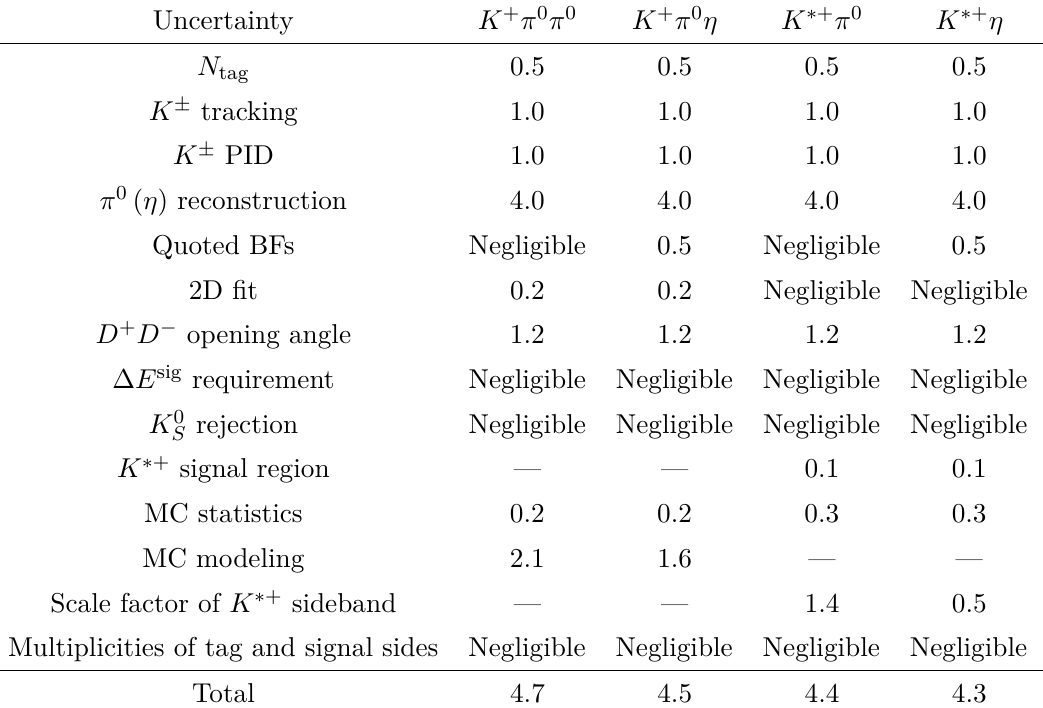
Table 3 . Systematic uncertainties (%) in the measurements of the